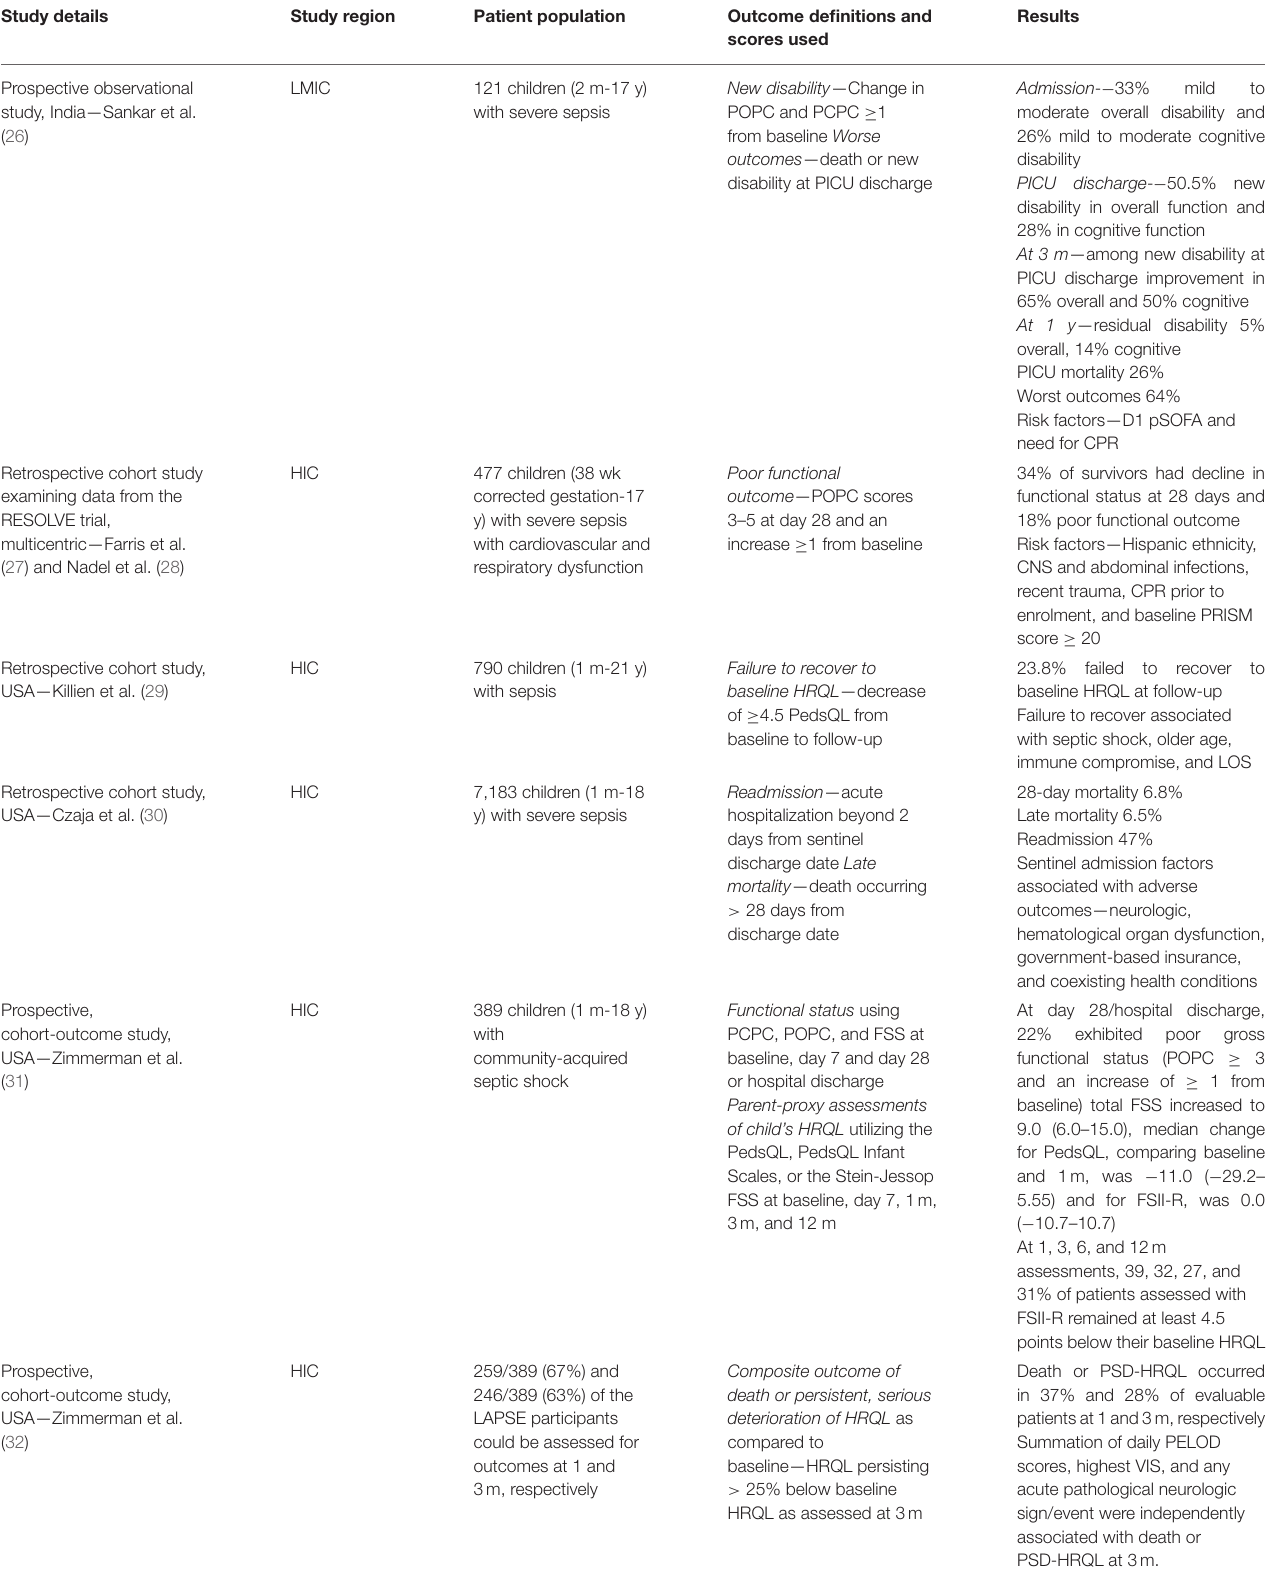
TABLE 1 | Studies on functional outcomes in pediatric